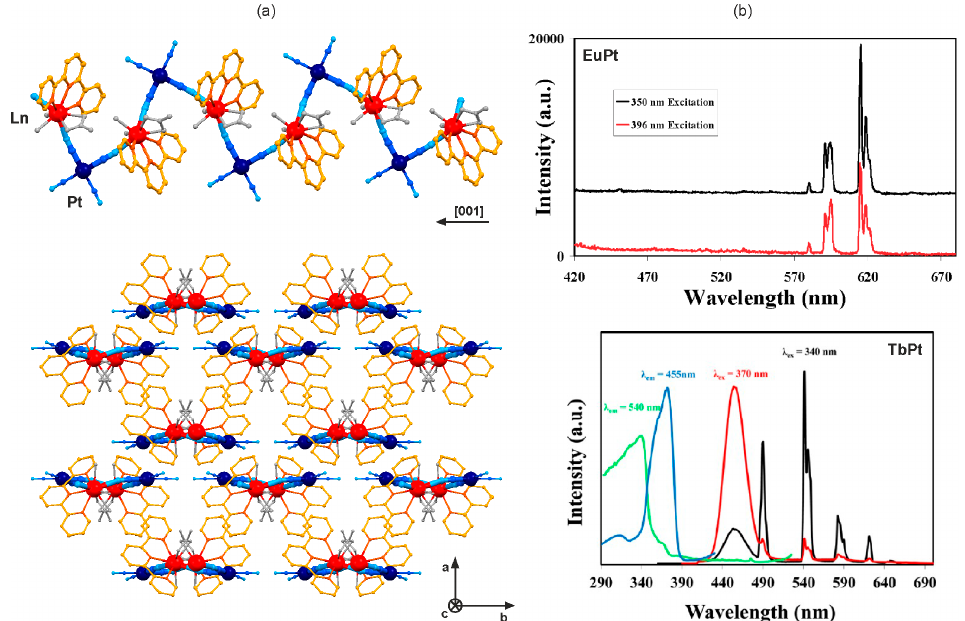
Figure 4. Crystal structure and optical properties of [Ln III (terpy)(H 2 O) 2 (NO 3 )][Pt II (CN) 4 ]· n (solvent) (Ln = Eu, Tb; terpy = 2,2’:6’2”-terpyridine) cyanido-bridged chains: ( a ) the views of the single coordination chain, and the arrangement of chains, ( b ) the low temperature ( T = 77 K) excitation-variable emission spectra for EuPt and TbPt compounds, with the related excitation spectra shown for TbPt. Colours for the structural diagram: Ln, red; Pt, dark blue; CN − , blue; terpy, orange; NO 3 − and H 2 O, grey. [81,87] Reprinted with permission from Inorg. Chem. 2008 , 47 ,